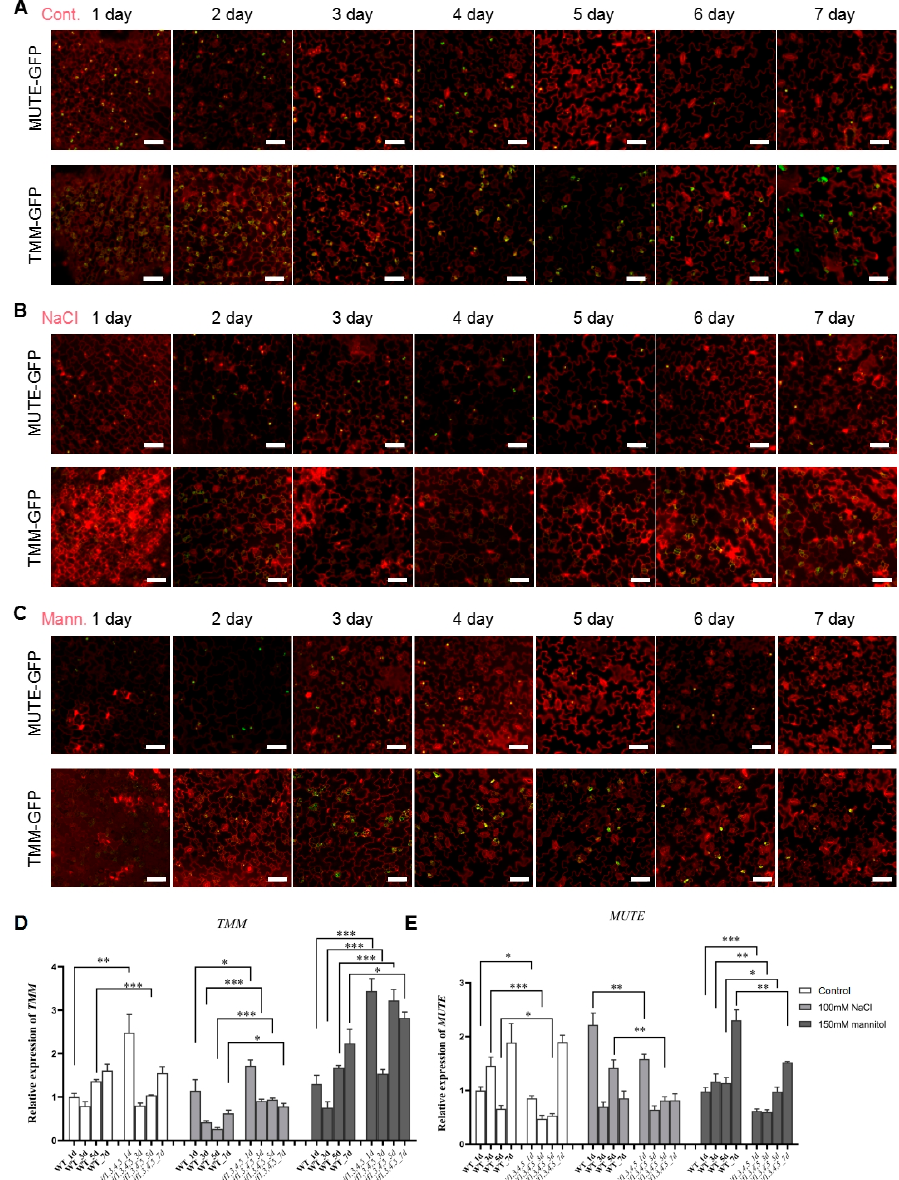
Figure 8 . Analysis of the effects of NaCl and mannitol on the expression of MUTE and TMM . ( A ) The seedlings of MUTE-GFP and TMM-GFP were grown in 1/2 MS plates for 1–7 days, then were harvested and stained with PI for 30 min to stain the membranes. After PI staining, the lower epidermis of cotyledons of seedlings was subjected to detecting the expression of GFP signals on laser confocal microscope. Scale bar: 50 μ m. ( B ) The seedlings of MUTE-GFP and TMM-GFP were grown in 1/2 MS plates plus 100 mM NaCl for 1–7 days, then were harvested and stained with PI for 30 min to stain the membranes. After PI staining, the lower epidermis of cotyledons of seedlings was subjected to detecting the expression of GFP signals on laser confocal microscope. Scale bar: 50 μ m. ( C ) The seedlings of MUTE-GFP and TMM-GFP were grown in 1/2 MS plates plus 150 mM mannitol for 1–7 days and then harvested and stained with PI for 30 min to stain the membranes. After PI staining, the lower epidermis of cotyledons of seedlings was subjected to detecting the expression of GFP signals on laser confocal microscope. Scale bar: 50 µ m. ( D , E ) qPCR analysis of the relative expression of TMM and MUTE under control, NaCl, and mannitol conditions, respectively. Relative expression indicates the mean value ( ± SD) of three independent experiments. The black stars represent student’s t -test of pif1/3/4/5 vs. WT. *: p < 0.05; **: p < 0.01; ***: p <